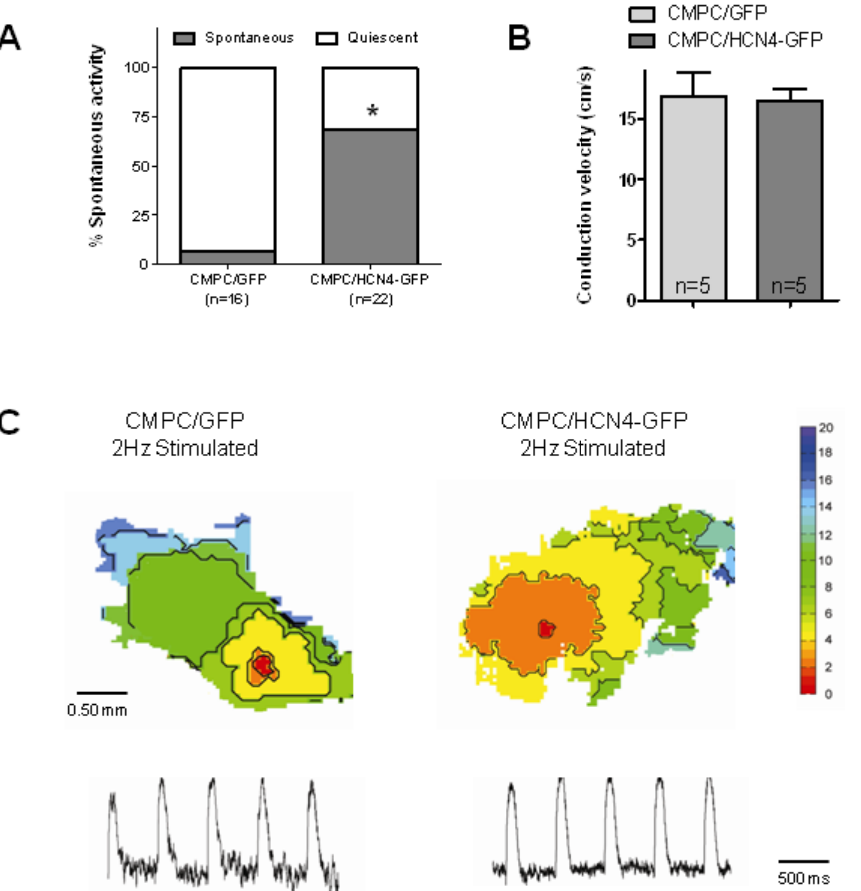
Figure 5. Baseline properties of organ explant cultures injected with CMPCs. ( A , B ) Summary data of spontaneous beating activity and conduction velocity of explants injected with CMPC/GFP and CMPC/HCN4-GFP. ( C ) Typical activation maps and optical action potentials measured during stimulation at 2 Hz. * indicates P < 0.05.